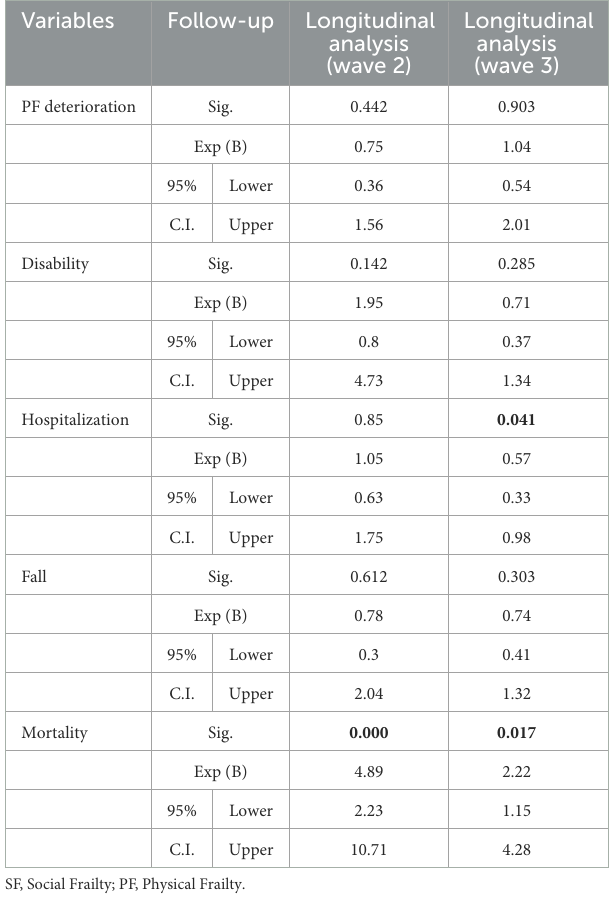
TABLE 3 Longitudinal analyses of SF with adverse health events.